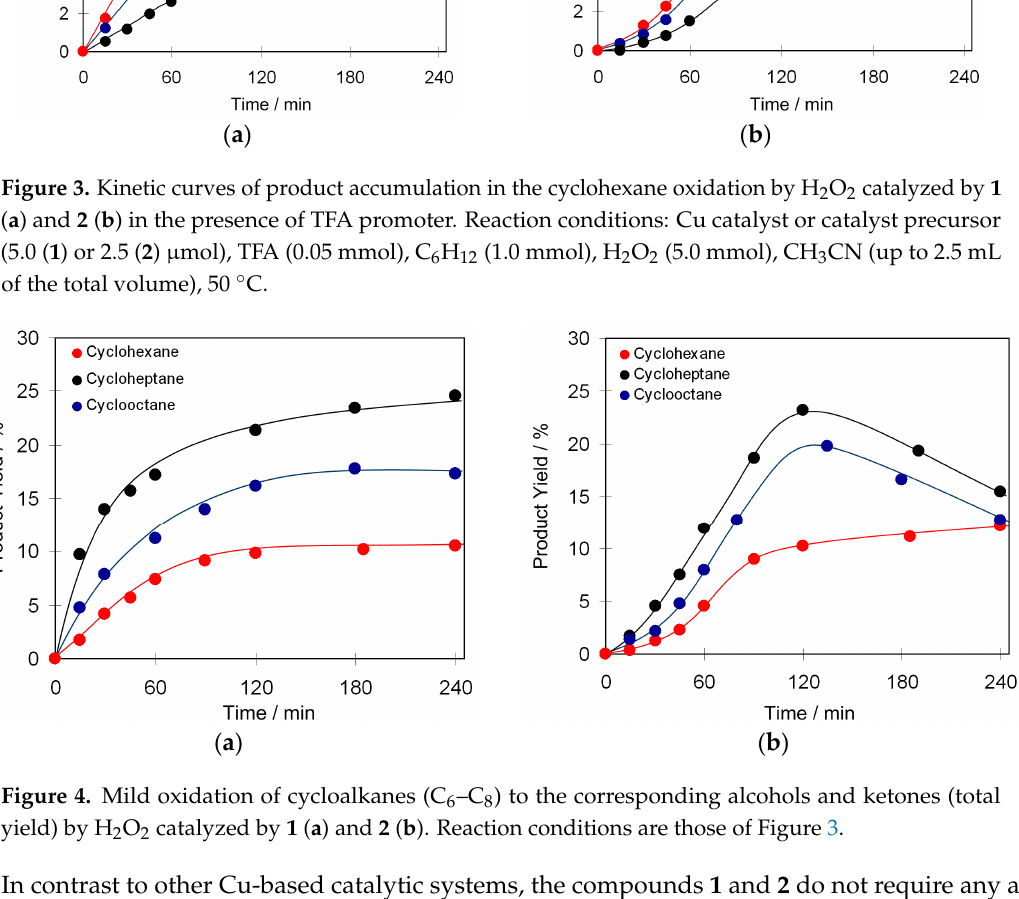
Figure 3. Kinetic curves of product accumulation in the cyclohexane oxidation by H 2 O 2 catalyzed by 1 ( a ) and 2 ( b ) in the presence of TFA promoter. Reaction conditions: Cu catalyst or catalyst precursor (5.0 ( 1 ) or 2.5 ( 2 ) µmol), TFA (0.05 mmol), C 6 H 12 (1.0 mmol), H 2 O 2 (5.0 mmol), CH 3 CN (up to 2.5 mL of the total volume), 50 °C.